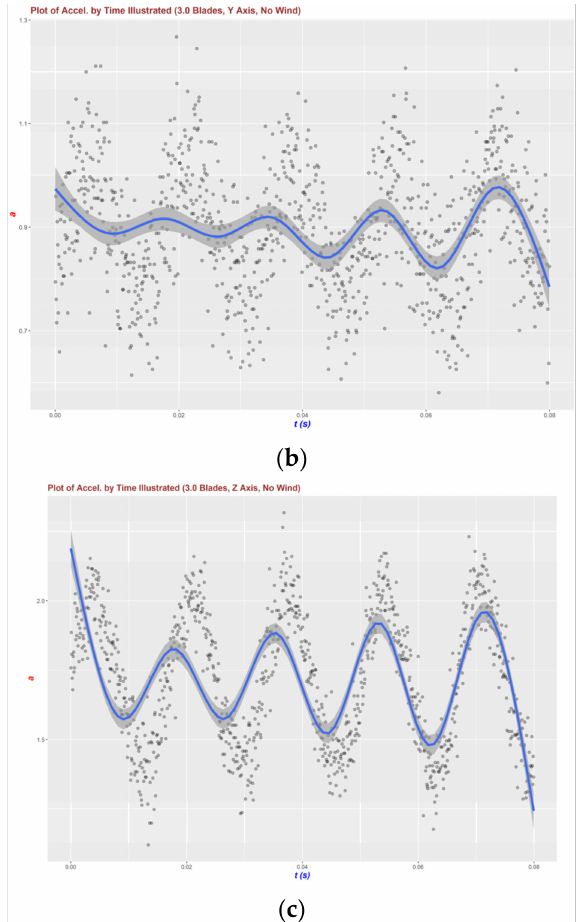
Figure 5. Magnitude and trend of acceleration for the full (normal) 3.0-blade turbine. ( a ) Based on datasets recorded along the X axis with no wind imposed. ( b ) Based on datasets recorded along the Y axis with no wind imposed. ( c ) Based on datasets recorded along the Z axis with no wind imposed.